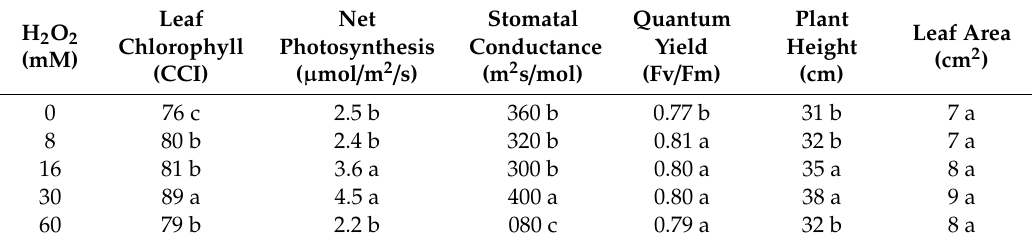
Table 1. The e ff ects of H 2 O 2 on plant physiological characters and growth of Ficus deltoidea plants on the 12th week of observation. All the data are a mean of five replicates. Di ff erent letters in the same column represent the significant di ff erence at 5% level. Chlorophyll content index (CCI); Variable fluorescence (Fv); Maximum fluorescence